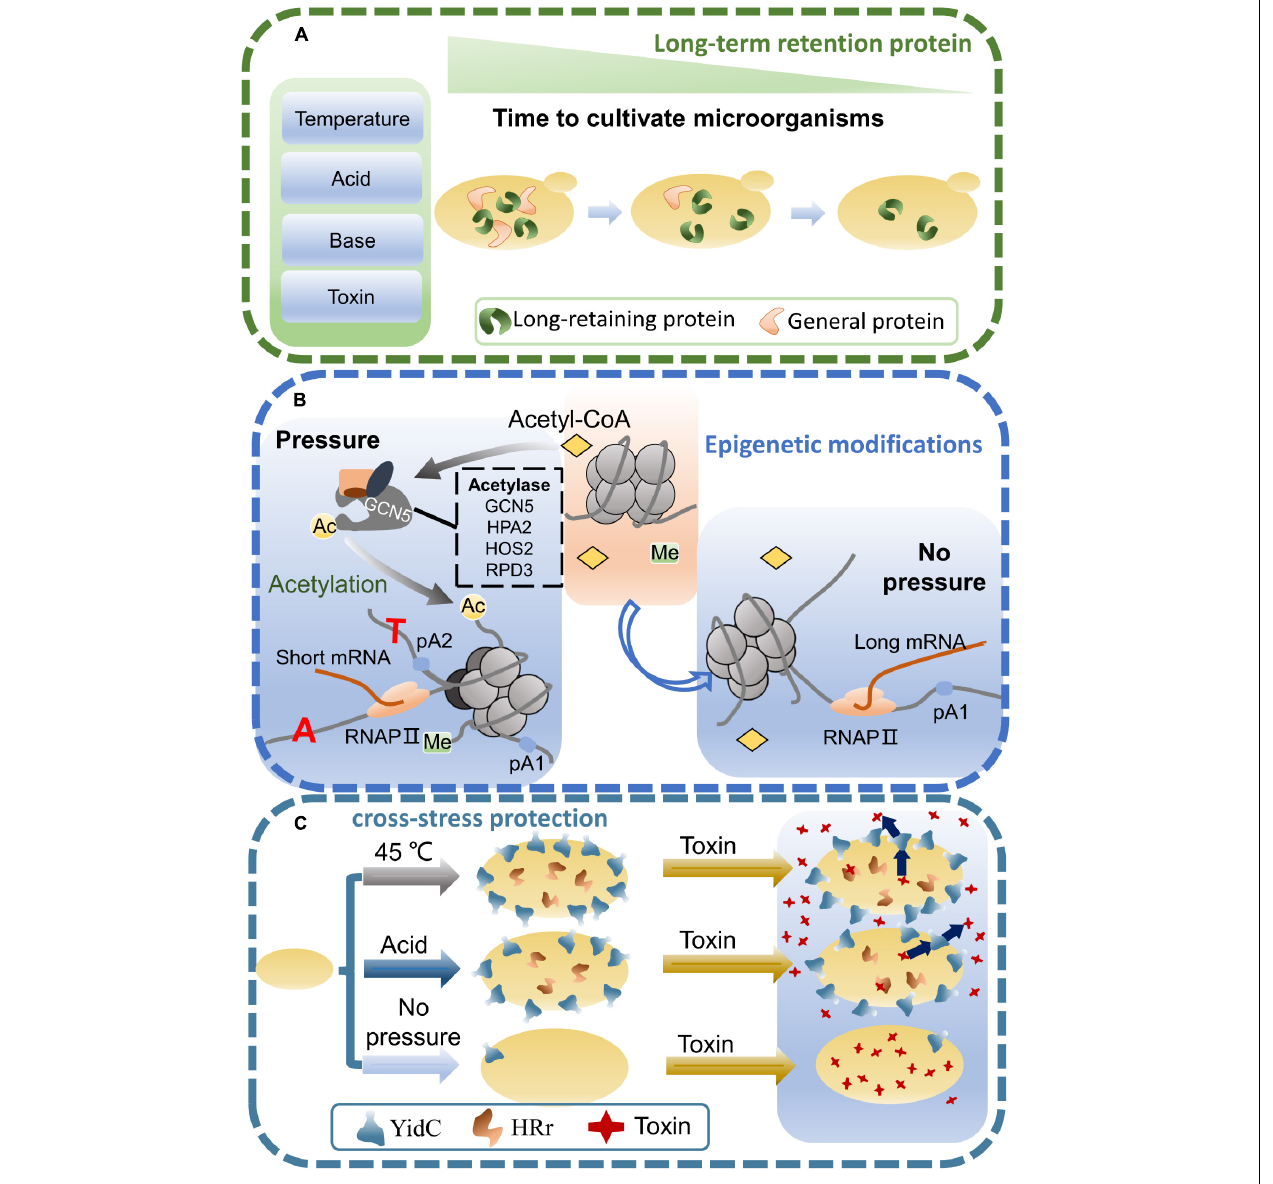
FIGURE 2 | Mechanisms of microbial stress adaptation. (A) When microorganisms are subjected to environmental stress, the long-retaining proteins are produced to protect the cells for a long time. (B) Effects of environmental stress on microbial epigenetic modifications. When microorganisms are stimulated by external environmental stress, epigenetic modifications are altered, affecting transcription and translation processes. (C) Microorganisms are adapted to a stressful environment, resulting in cross protection against stress. Growth advantages can also be shown when switching to other stressful